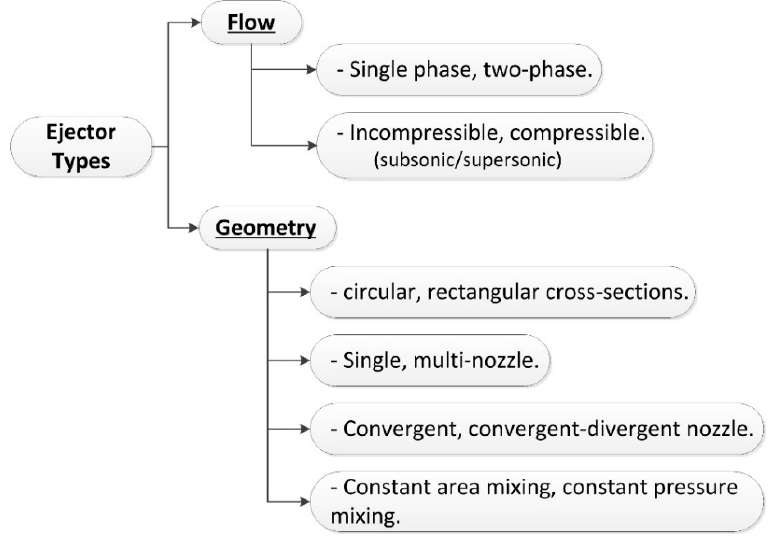
Figure 2. Main ejector types.